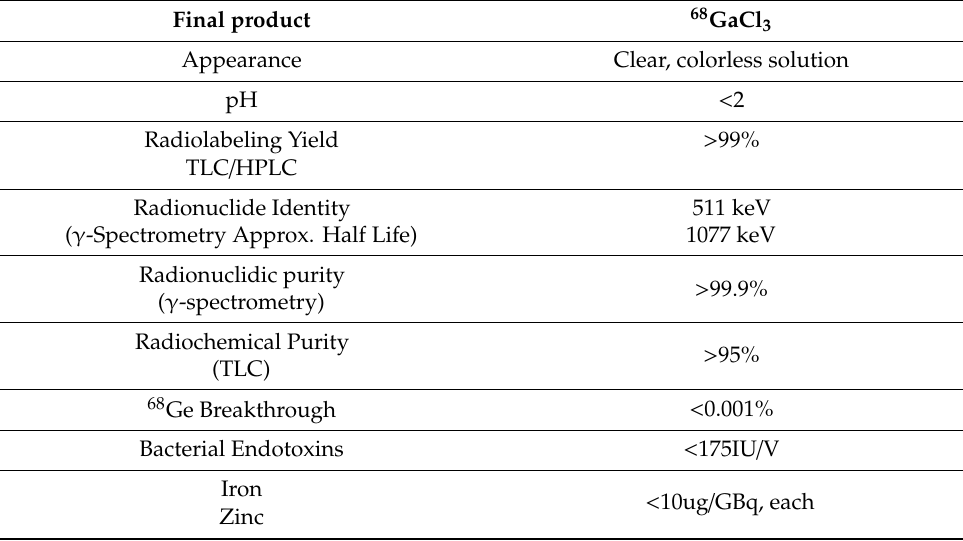
Table 4. Specification for generator-produced 68 Ga [147].